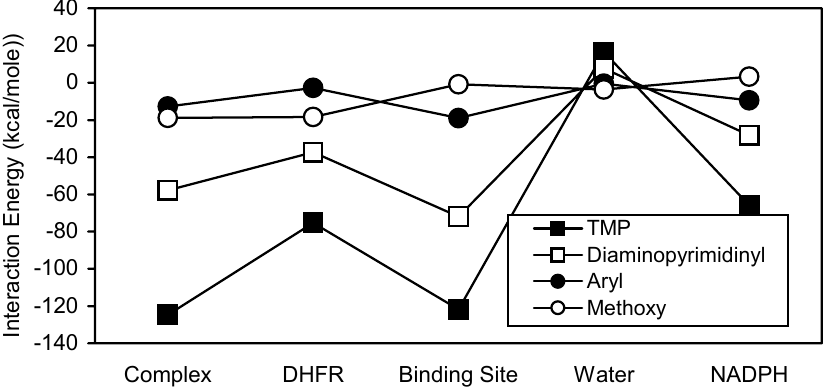
Figure 5 . Comparison interaction energy analysis of TMP and its substructural regions.